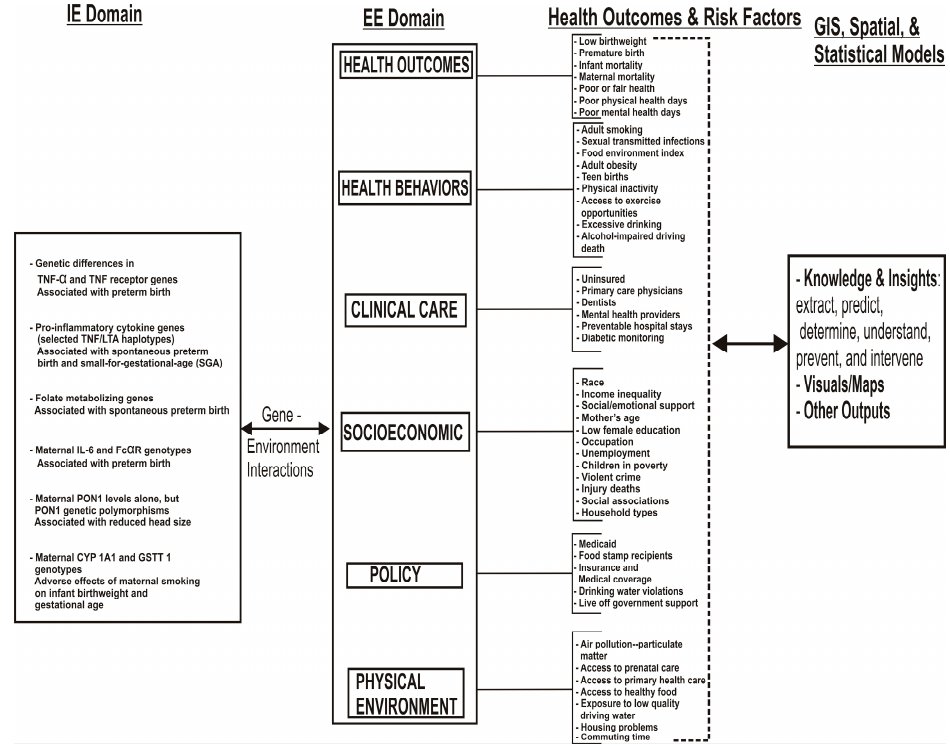
Figure 1. A conceptual framework for understanding adverse birth outcomes synthesized from over 50 research articles. IE refers to internal exposome while EE is the external exposome.